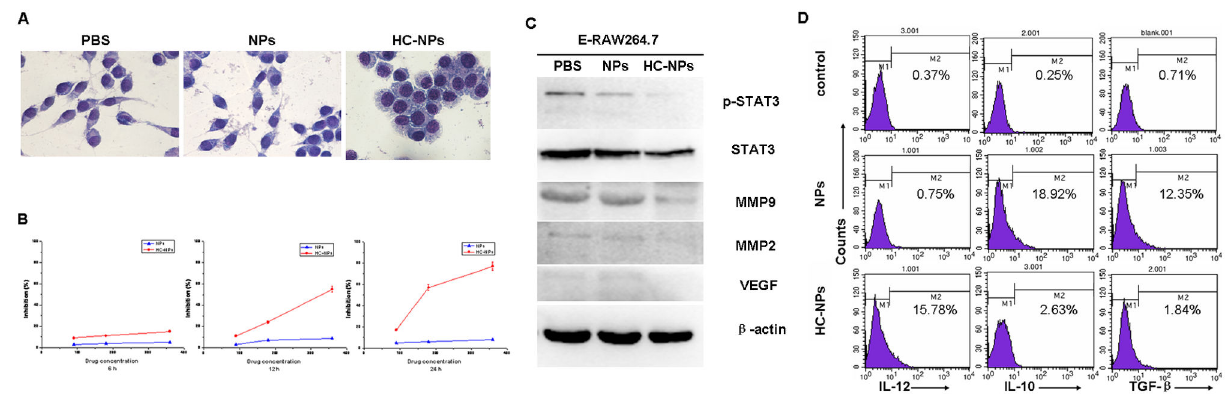
Figure 2. HC-NPs “re-educate” TAMs phenotype from M2 to M1 following STAT3 suppression. (A) HC-NPs affected morphological changes of E-RAW264.7 cells; PBS, NPs, HC-NPs represented cells were treated with PBS, NPs, 180µM HC-NPs for 12 hours respectively (Wrights staining, Magnification×100.0). (B) MTT demonstrated HC-NPs inhibited growth of E-RAW264.7 cells in a manner of time-concentration-dependence, after treated 6h, 12h, 24 h. (C) Decreased p-STAT3, MMP-2, MMP-9 and VEGF protein expression of E-RAW264.7 cells after treated with HC-NPs. PBS, NPs, HC-NPs represented cells were treated with PBS, NPs, 180µM HC-NPs for 12 h respectively. (D) FACS demonstrated downregulation of M2macrophages intracellular markers in RAW264.7 after treated with HC-NPs,